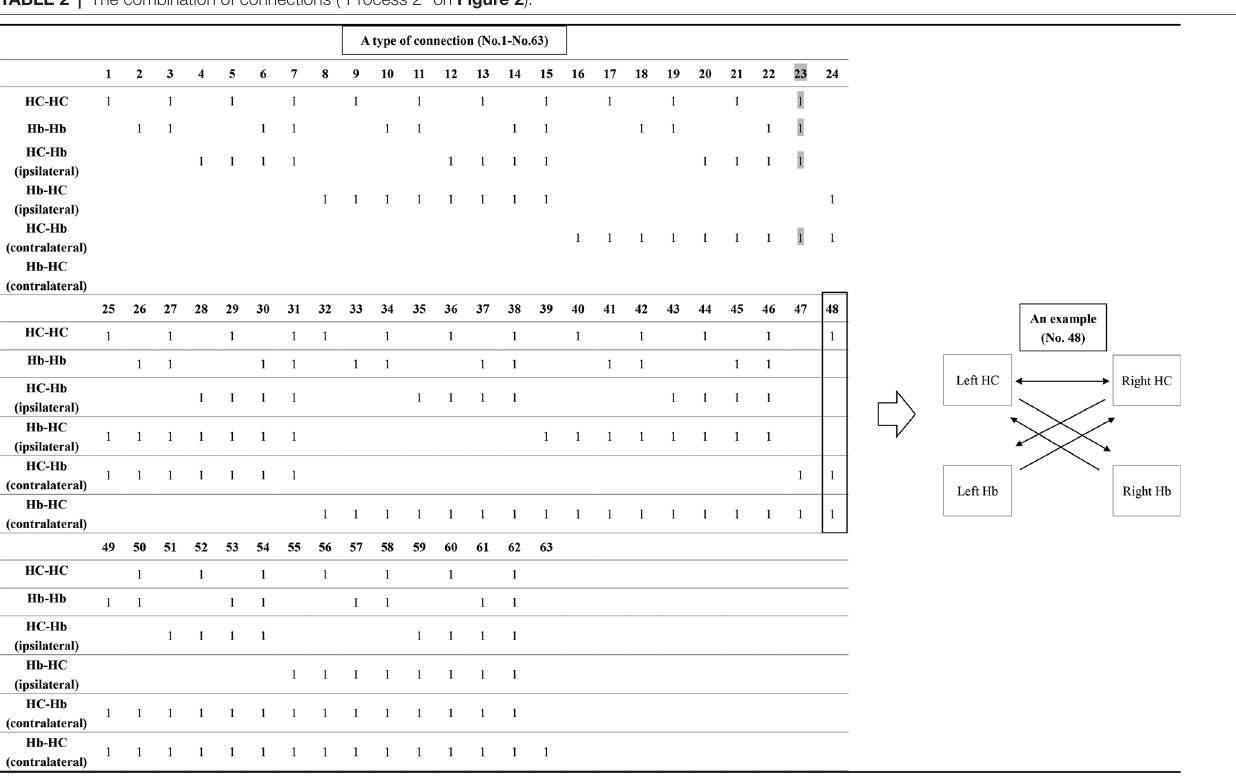
TABLE 2 | The combination of connections (“Process 2” on Figure 2